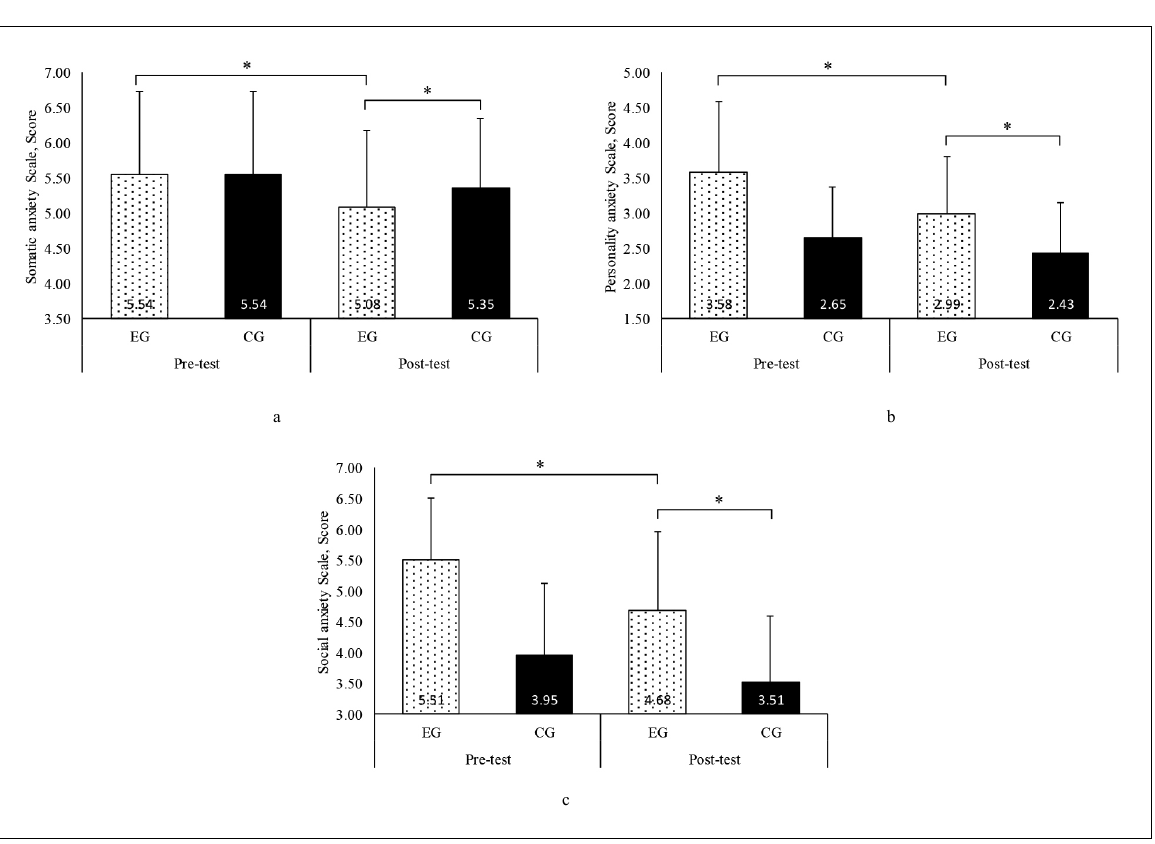
Figure. The level of elementary school children’s somatic anxiety (a), personality anxiety (b), and social anxiety (c) in the pre-test and